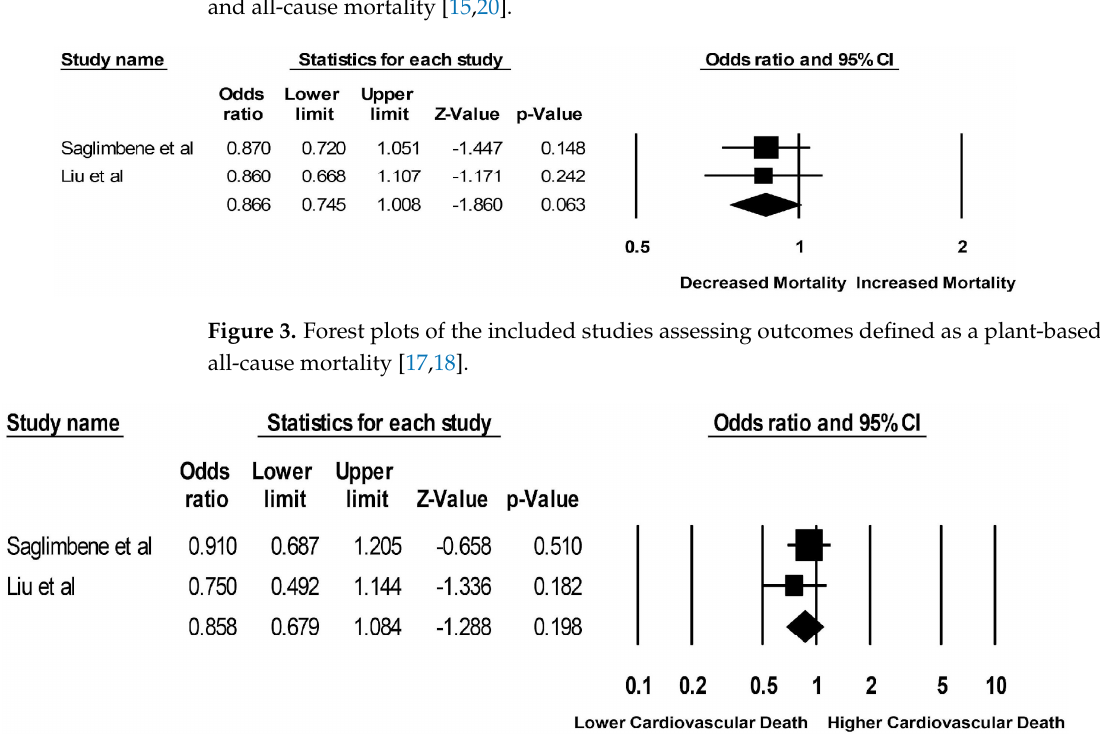
Figure 4. Forest plots of the included studies assessing outcomes defined as a plant-based diet and cardiovascular mortality.